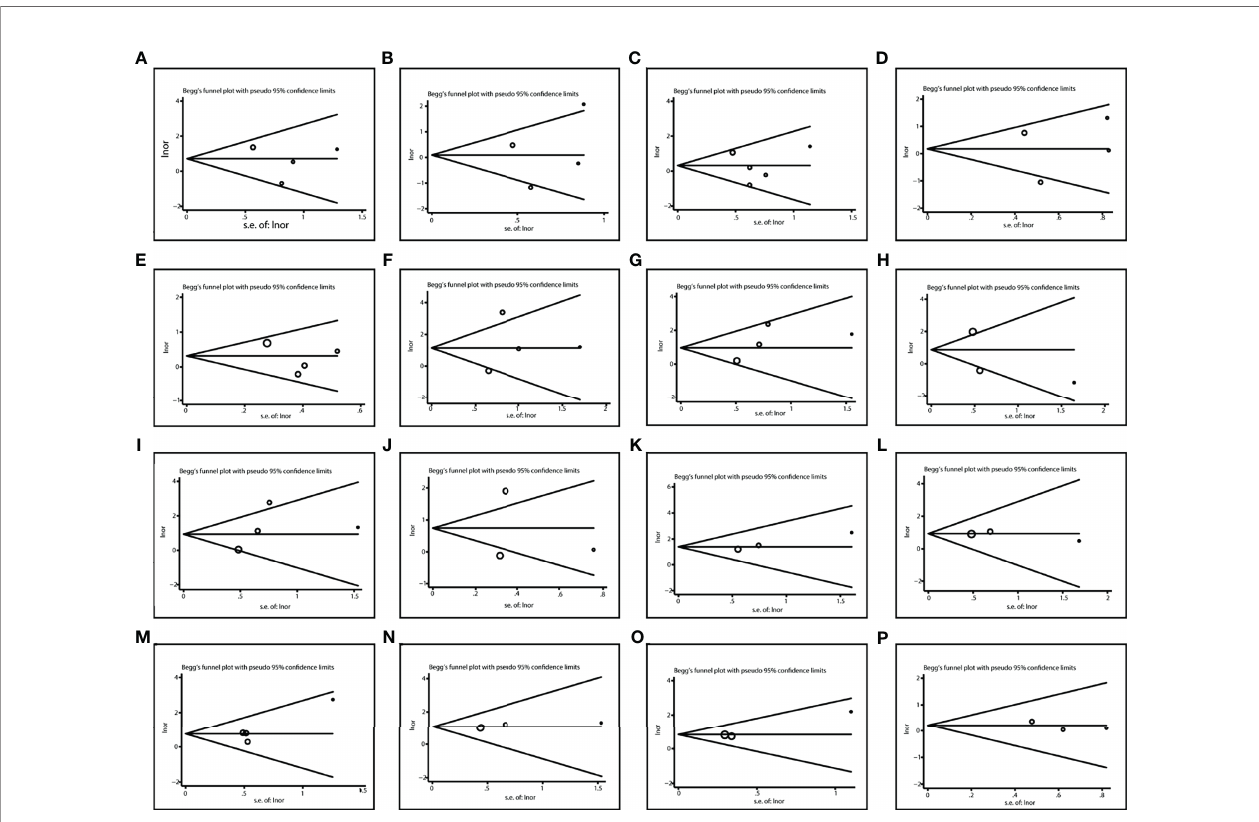
FIGURE 7 | Publication bias in various comparisons. (A) TT vs CC in liver toxicity; (B) TC vs CC in liver toxicity; (C) TT vs. TC/CC in liver toxicity; (D) TT/TC vs. CC in liver toxicity; (E) T vs C in liver toxicity; (F) TT vs CC in kidney toxicity; (G) TC vs CC in kidney toxicity; (H) TT vs. TC/CC in kidney toxicity; (I) TT/TC vs. CC in kidney toxicity; (J) T vs. C in kidney toxicity; (K) TT vs CC in Mucositis; (L) TC vs CC in Mucositis; (M) TT vs. TC/CC in Mucositis; (N) TT/TC vs. CC in Mucositis; (O) T vs. C in Mucositis; (P) TT vs. TC/CC in